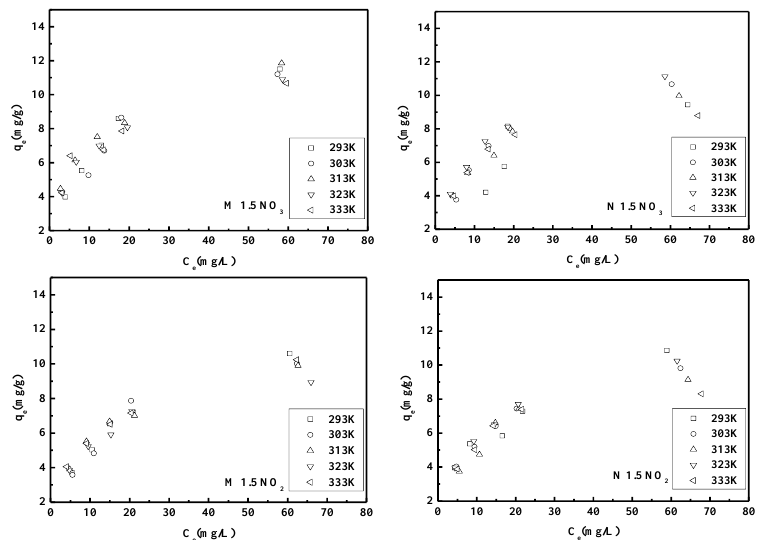
Figure 7. Adsorption isotherm of M 1.5 and N 1.5 at different temperatures (293–333 K). Adsorption capacity of nitrate for ( a ) M 1.5 and ( b ) N 1.5; adsorption of nitrite for ( c ) M 1.5 and ( d ) N 1.5 (dose of adsorbent = 4 g/L, pH =